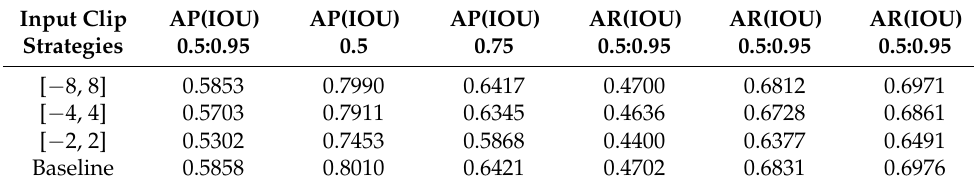
Table 1. Results of three input clip strategies in float type during